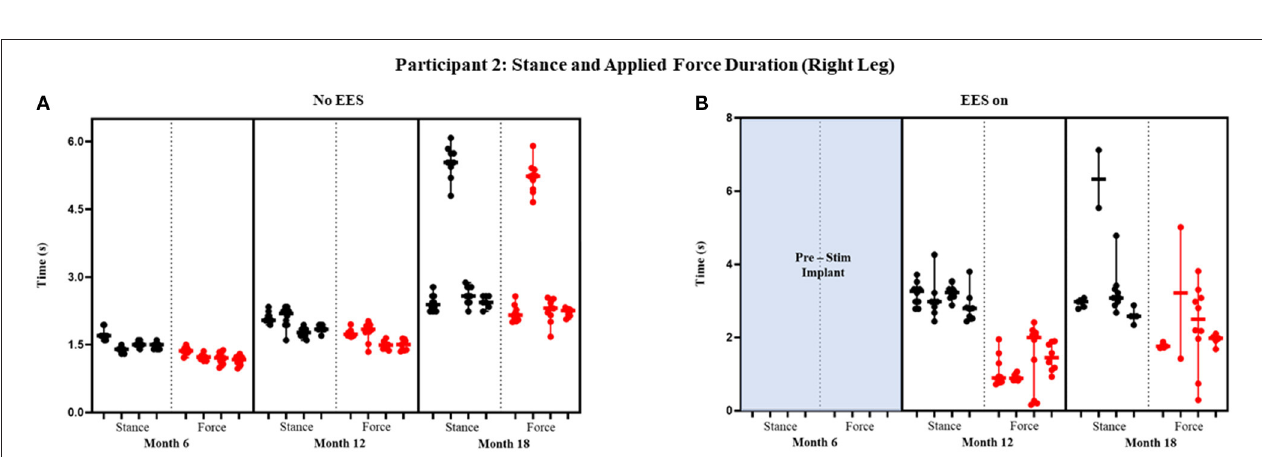
Frontiers in Rehabilitation Sciences |